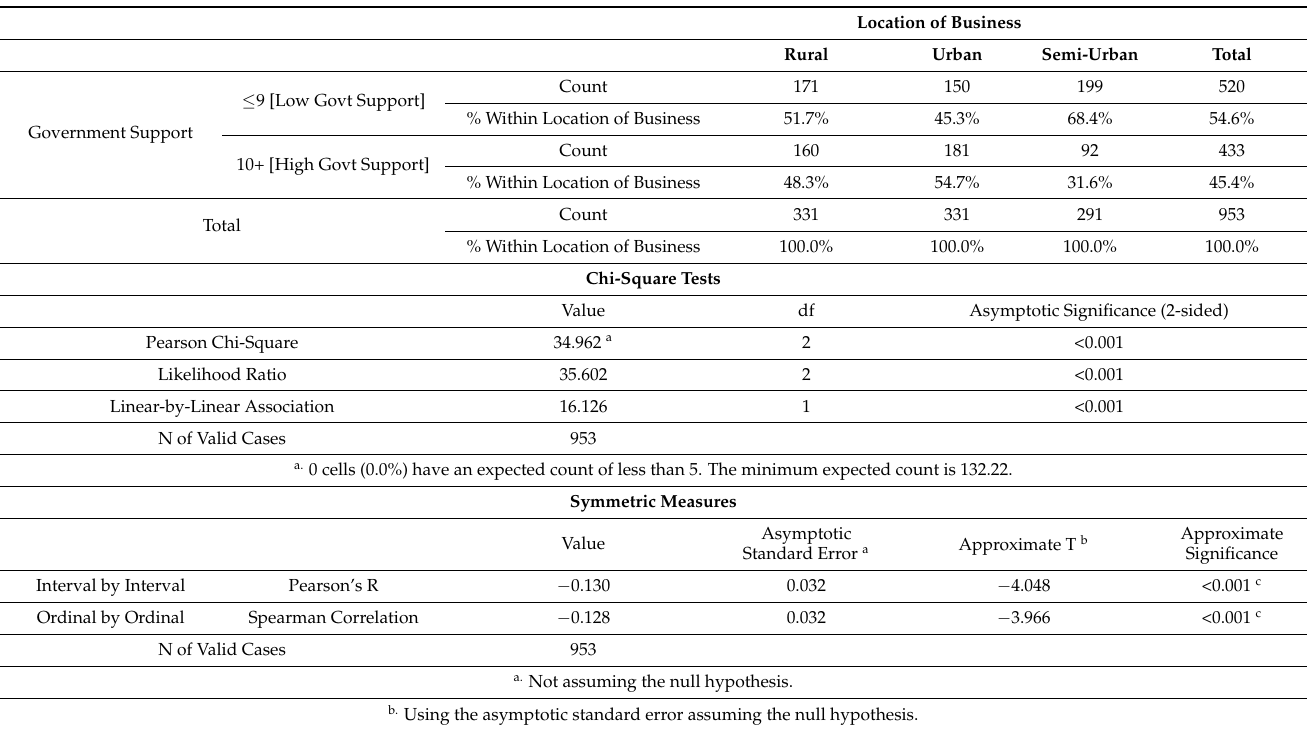
Table 3. Government support score * location of business